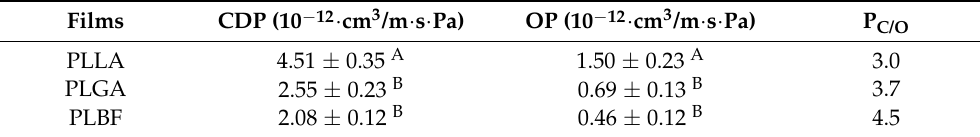
Table 3. Gas barrier properties of PLLA/PLGA/PLBF modified atmosphere breathing